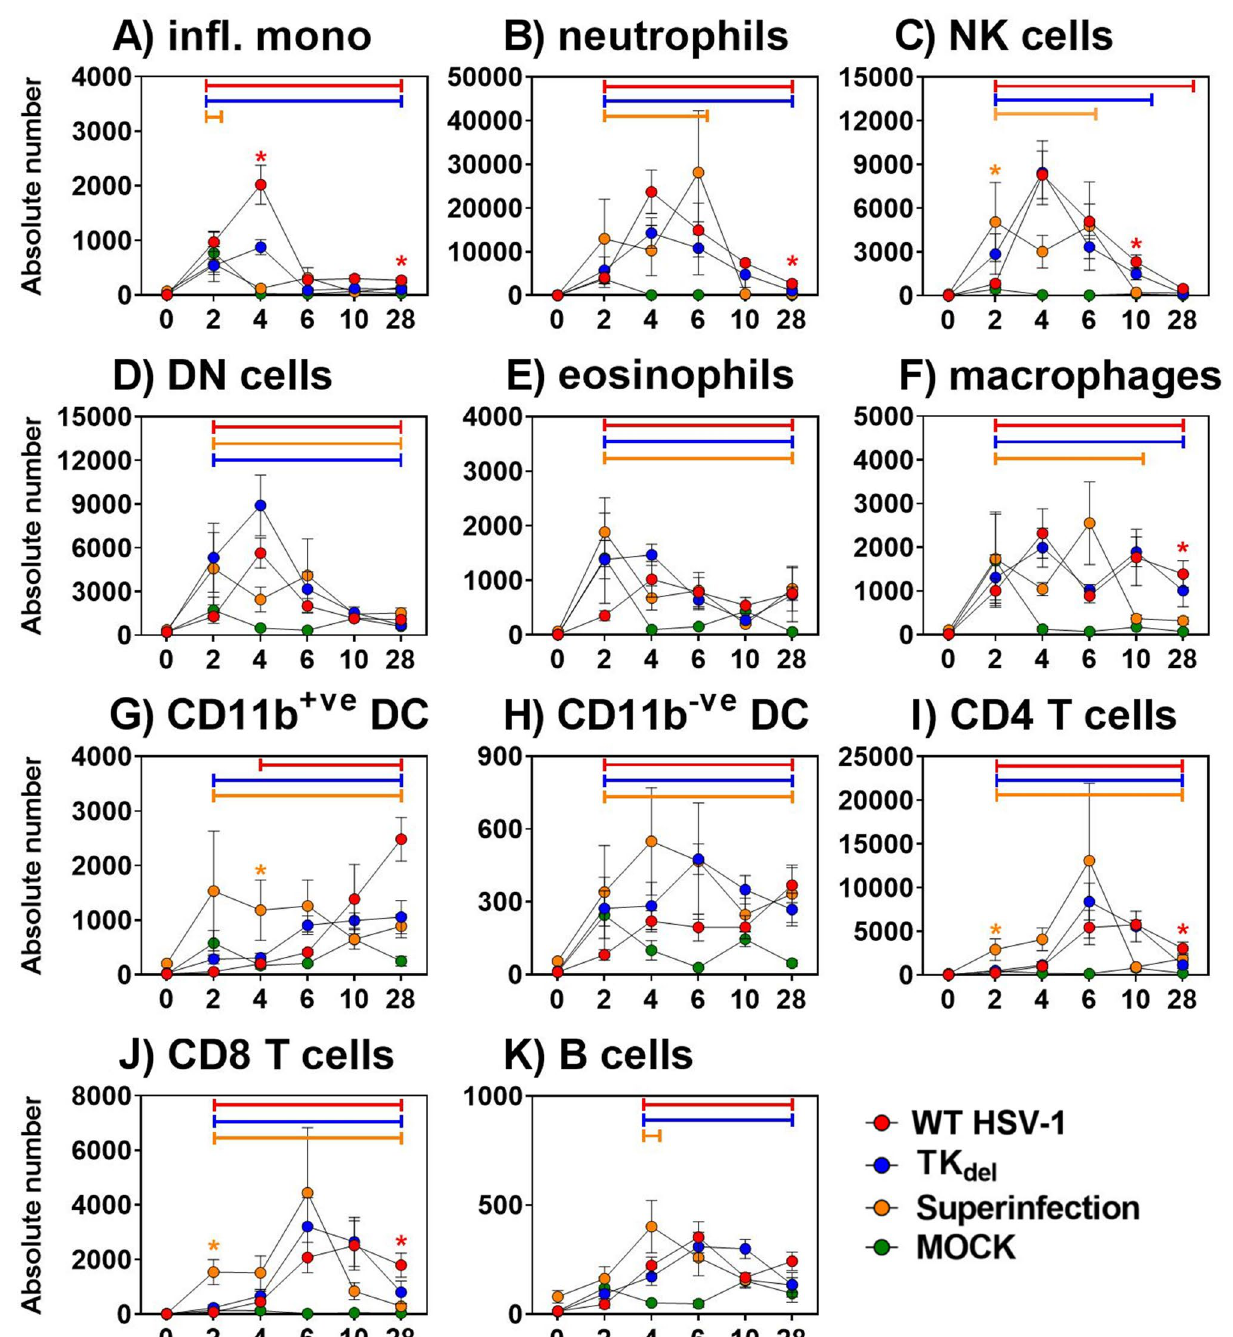
Figure 5. Immune subsets at the lip site of inoculation. Naïve mice were infected on day 0 with WT HSV-1, PBS (mock), or TK del . Mice of the superinfection model received an initial inoculation of TK del in the right lip on day -4, and were superinfected on day 0 in the left lip with WT HSV-1. On different days in each group, immune subsets ( A – K) were defined and absolute numbers quantified by flow cytometry from single cell suspensions of the lip site of virus inoculation. Colored bars indicate significance from uninfected tissue on day 0. Red asterisks indicate a significant difference for unprimed WT HSV-1-infected mice compared to PBS mock infection (green) and superinfection model mice, and orange asterisks indicate significance for superinfection model compared to Mock and WT HSV-1, and ( p < 0.03; permutation test ). Each point represents n = 4 individual biological replicates. Figures were formulated using Flowjo, Excel and